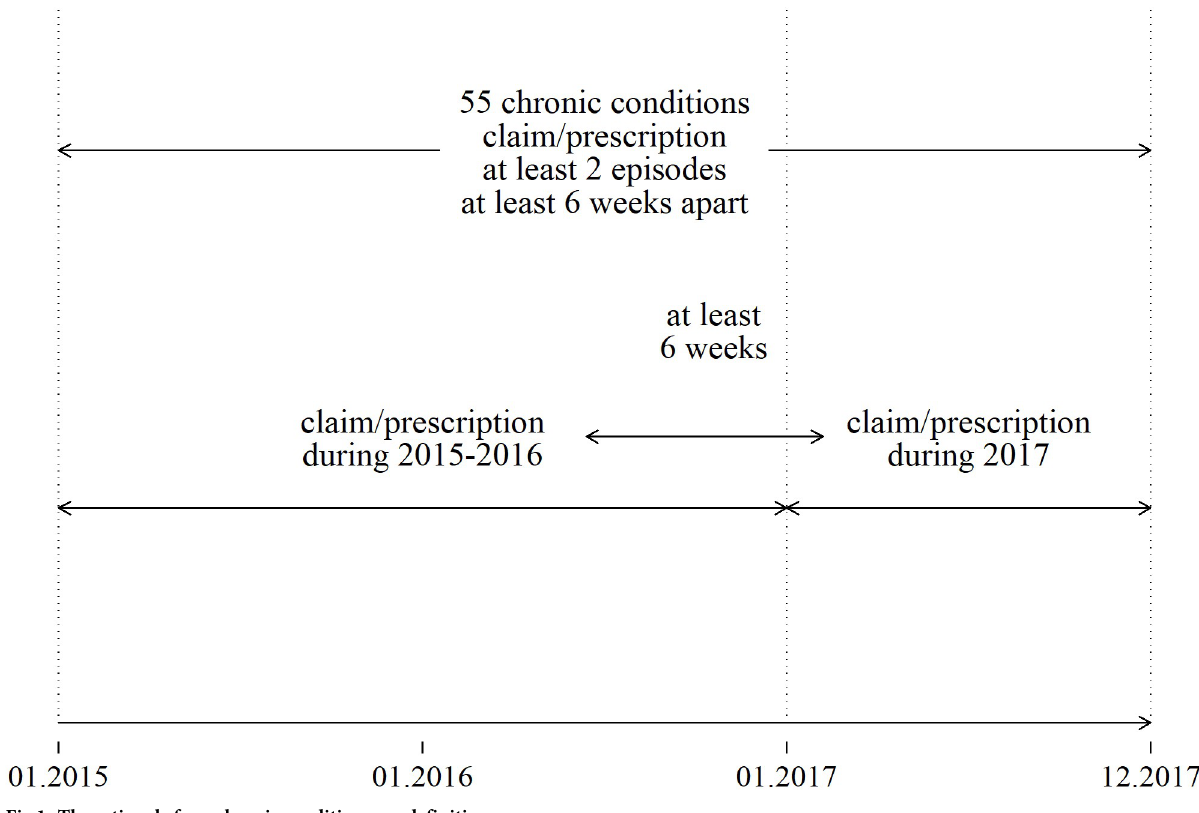
Fig 1. The rationale for a chronic condition case